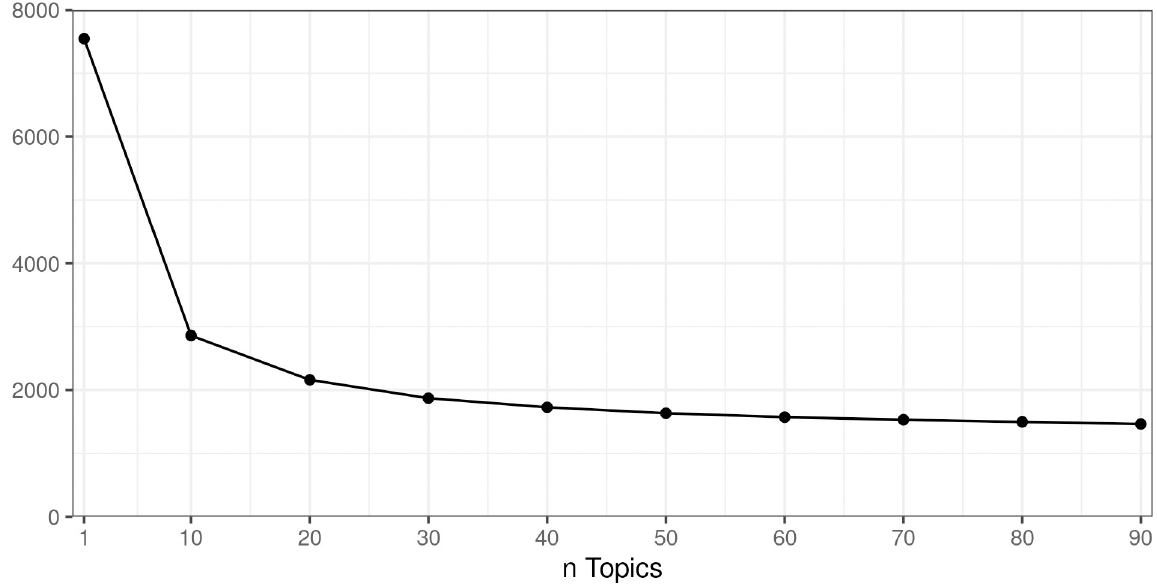
Fig 8. Perplexity score per number of topics for those 3,747,055 health-related web pages that belong to the three times 1000 top-ranked web sites from the sGHW.